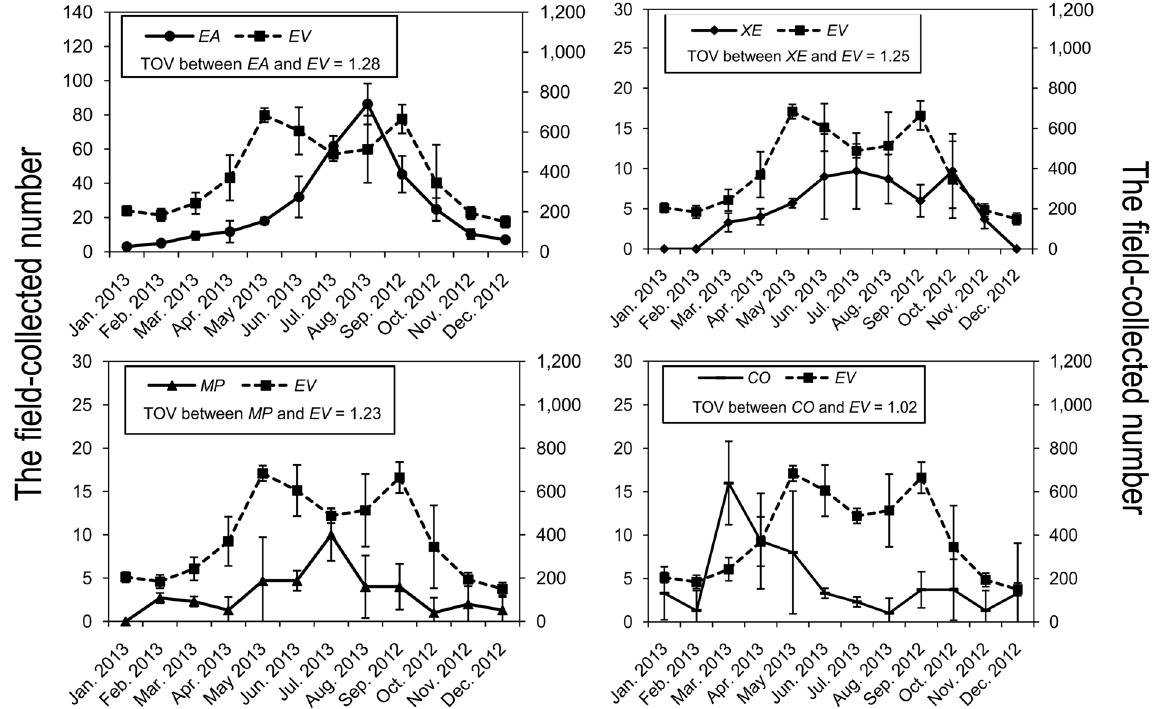
Figure 2. Population dynamics of E . vitis and four dominant spider species in the canopies of tea. Values presented as mean ± SD (N = 3). Temporal overlap values (TOV) between spider species and E . vitis was estimated by following measure, developed by Hurlbert 61 : = ∑ spatial overlap measure of species i on species j , S is the unit number of resource sequence, P ih is the proportion that resource h is of the total resource that species i utilizes and P jh is the proportion that resource h is of the total resource that species j utilizes. E . vitis : EV ; E . albaria : EA ; X . ephippiatus : XE ; M . pulcherrima : MP ; C . octomaculatum : CO